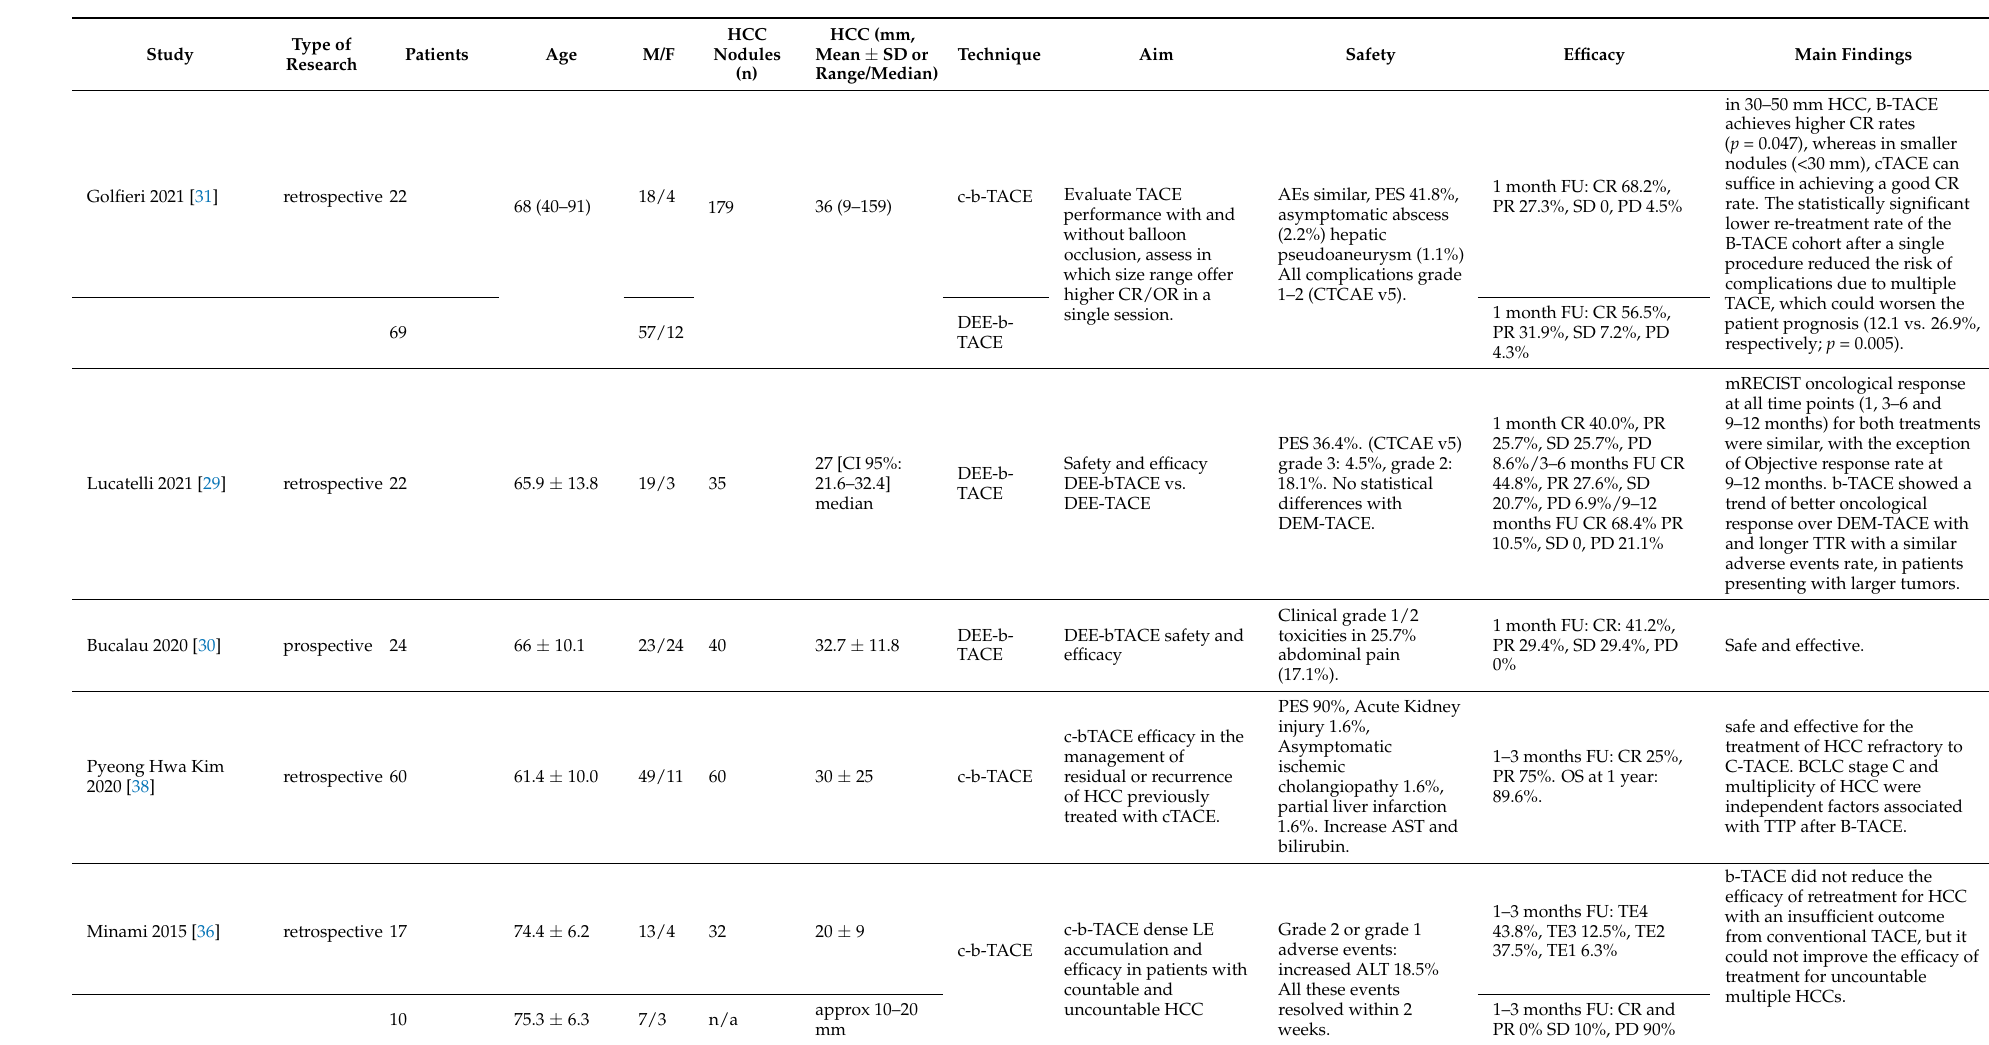
Table 2. Summaries of studies focused on safety and efficacy of